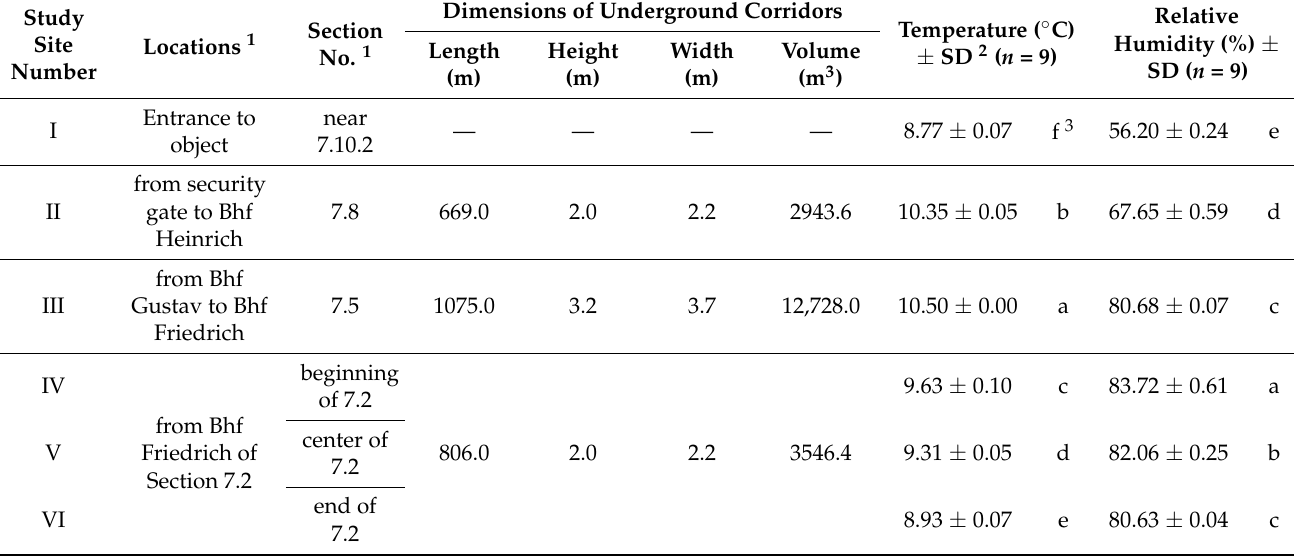
Table 1. Study sites and average values of microclimatic conditions in parts of the Nietoperek bat reserve underground investigated for aeromycology: 1 See Figure 1 for locations. 2 SD (standard deviation). 3 For each location, microclimatic conditions followed by the same letter are not statistically different at the α ≤ 0.05 level, according to Tukey’s HSD test; others are. Letters indicate the effect of location on particular conditions in the Nietoperek bat reserve; they refer to means along the columns.